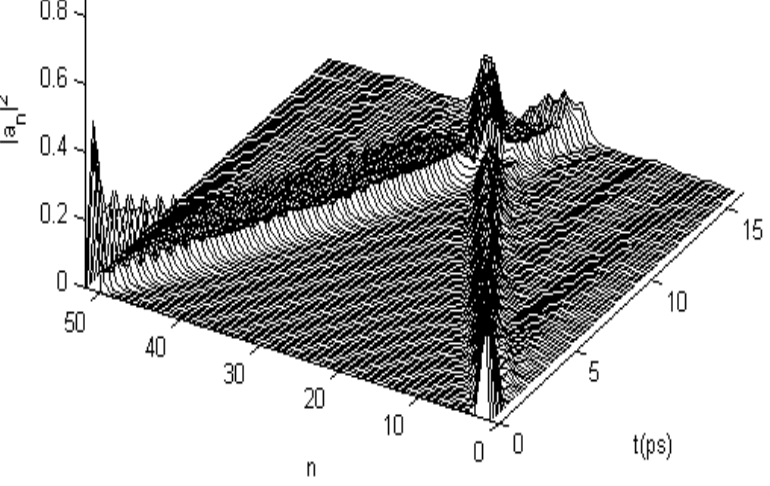
Figure 3. The collision behavior of two solitons for Equations (18)–(21).